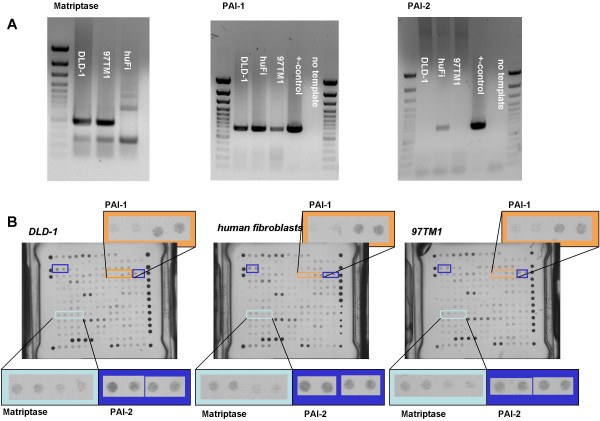
Comparison of PCR vs. hybridization pattern on the arrays. A. Electrophoresis of PCR products. Initially reverse transcribed c-DNA of human fibroblasts, DLD-1 and 97TM1 was used as template for PCR with specific primers for Matriptase, PAI-1 and PAI-2. Positive controls: plasmid-cDNAs of the three targets, negative controls were template free. Product sizes: matriptase 470 bp, PAI-1 687 bp, PAI-2 710 bp. B. Array analysis. Sample preparation was performed according to the protocol for overall linear amplification with the SPA primer and simultaneous labelling (see Methods part).